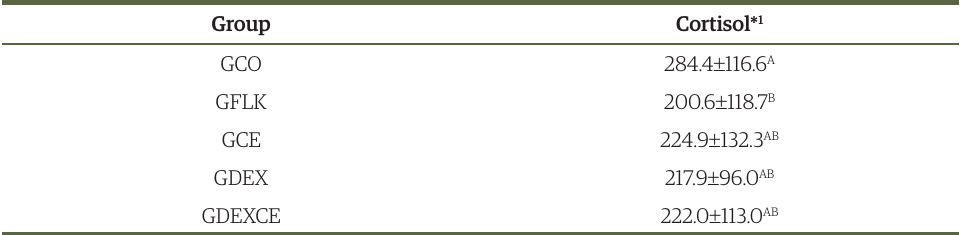
Table 4. Cortisol values (nmol/L) in the groups.